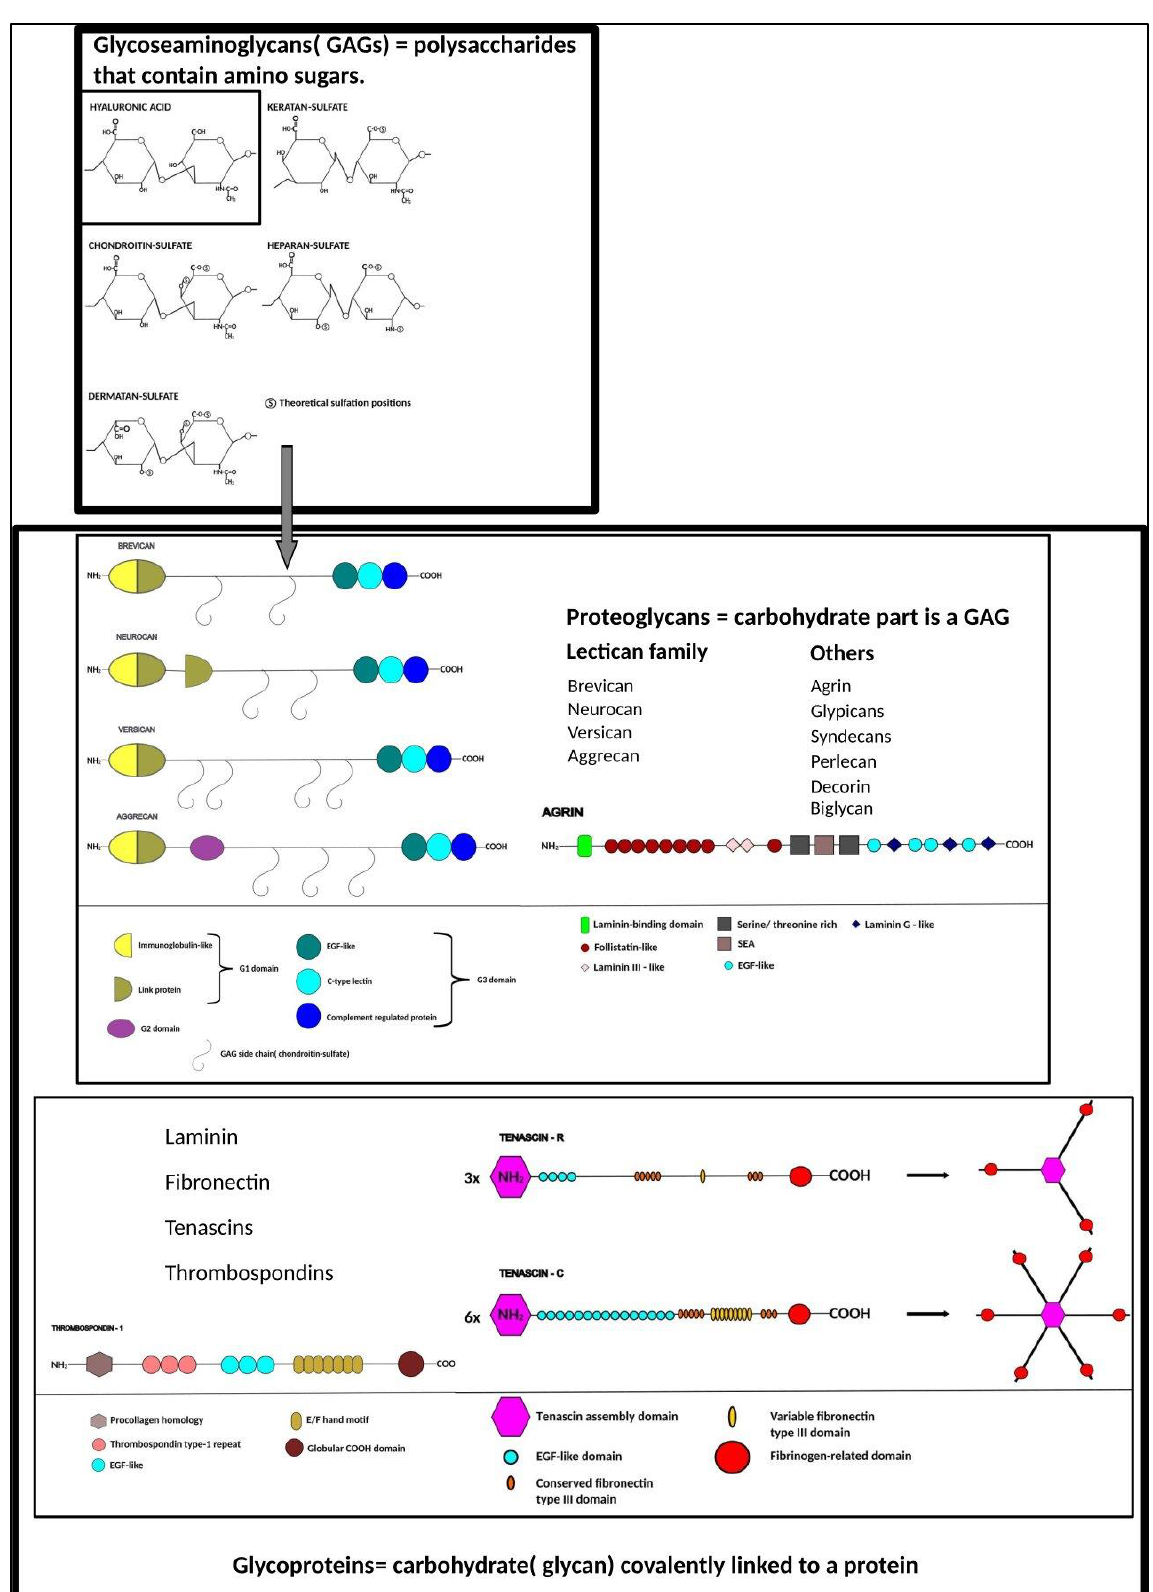
Figure 1. Typical components of central nervous system extracellular matrix “ground - substance”.